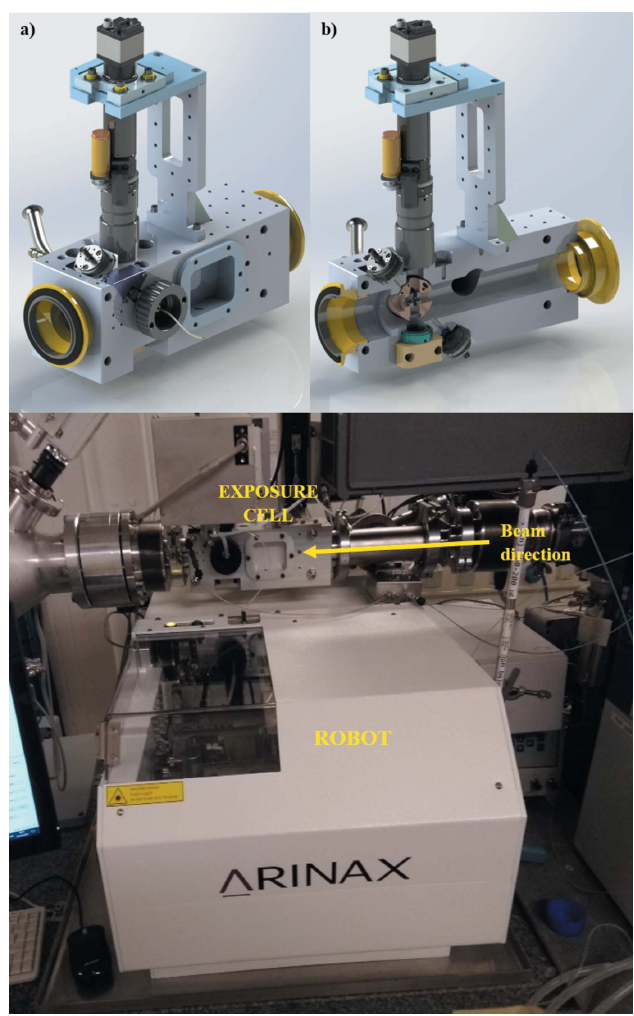
Figure 4 (Top) CAD design of the new SEU2A exposure ( a ) and a cut-through showing the position of the capillary and ports for spectrographic inserts ( b ). (Bottom) The SEU2A exposure cell in situ with new sample-changer robot.